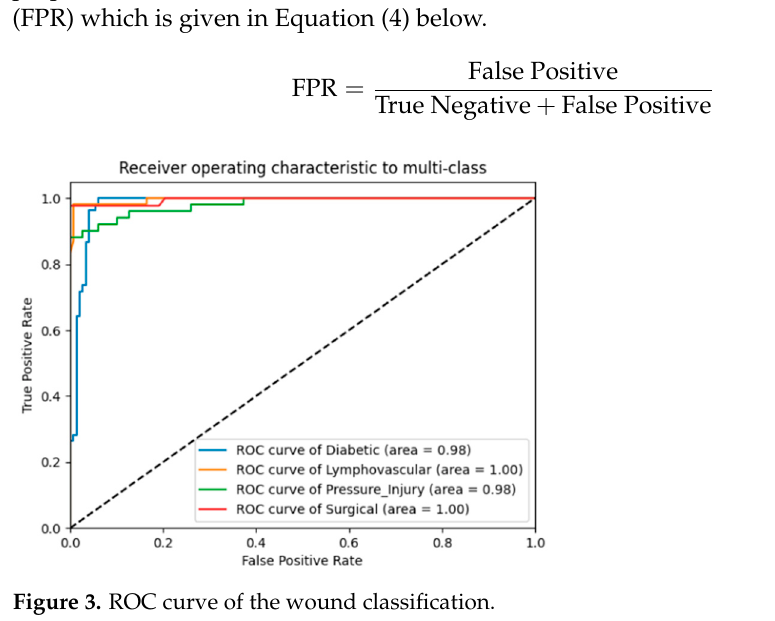
Figure 3. ROC curve of the wound classification.